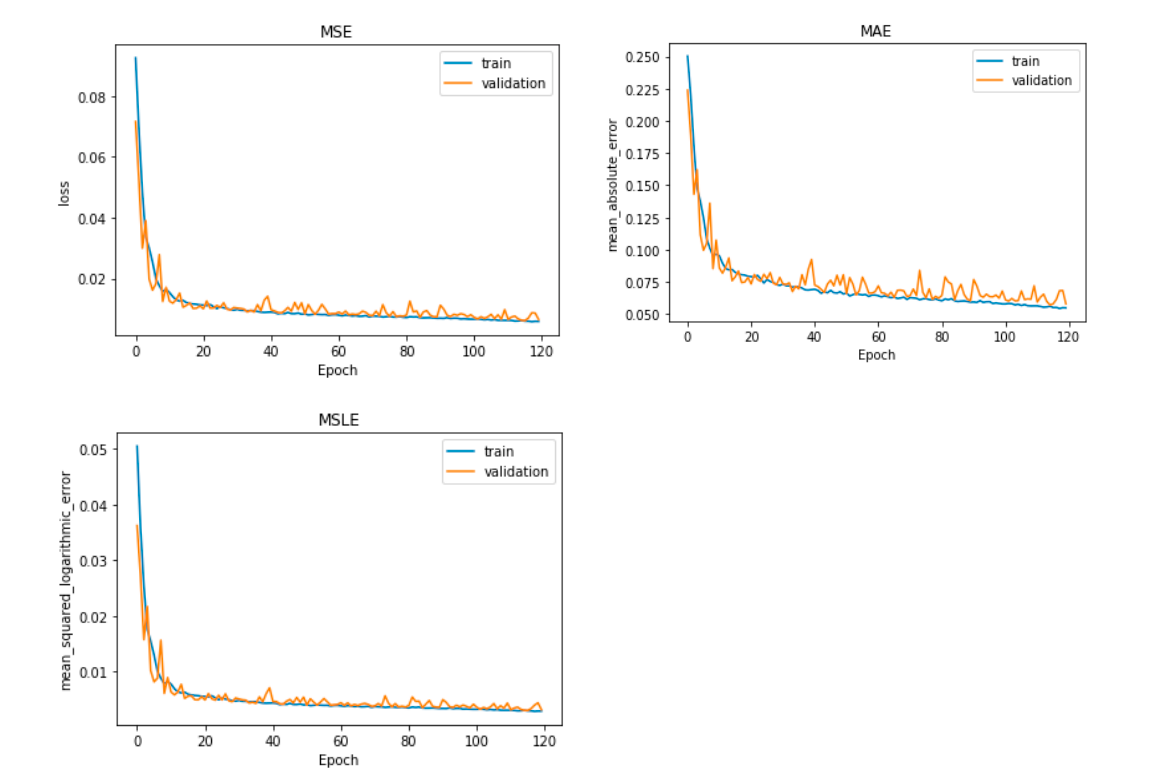
Figure 3. Multiple inverters and model predictions with the same A-11 feature variable information (LSTM) .